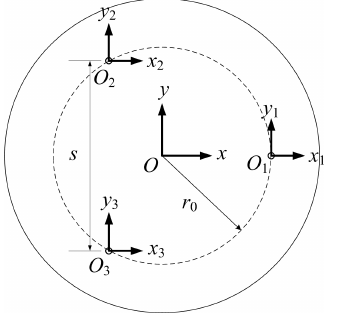
Figure 3. Top view of a PLCM.